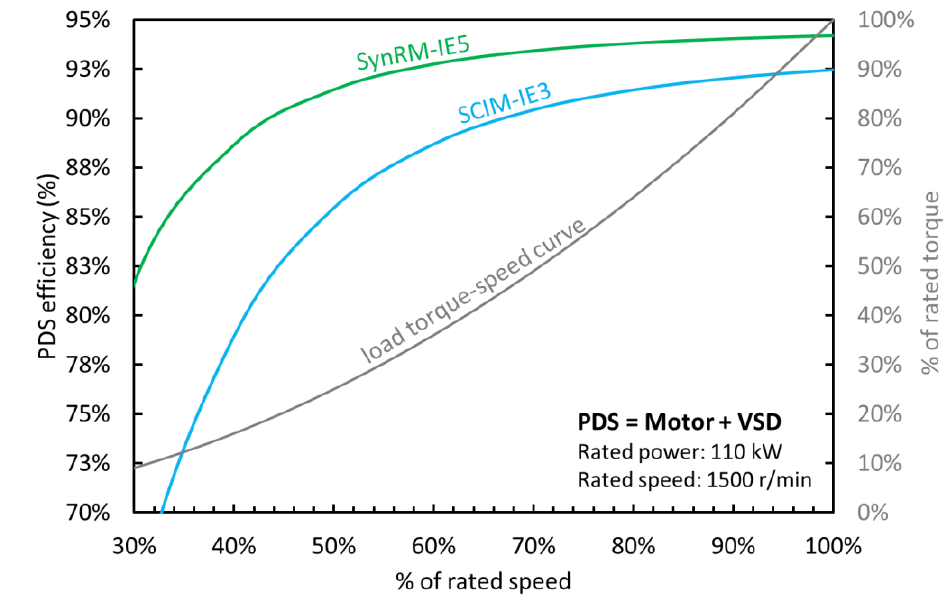
Figure 7. Efficiency comparison of an 110-kW PDS (Power Drive System) with IE3-class SCIM and with IE5-class SynRM considering a quadratic-torque load fan or pumping system without static head. (Source: Authors).